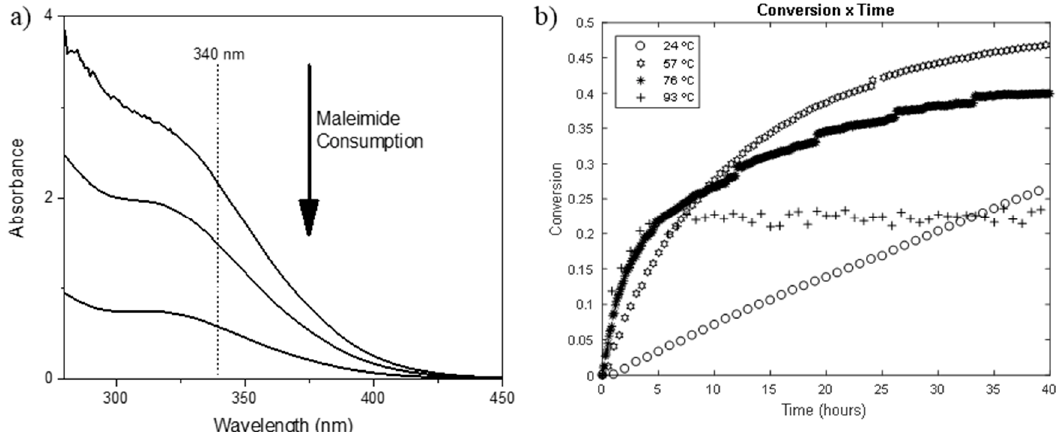
Figure 1. ( a ) UV-Vis spectra showing the decrease of absorbance attributed to the disappearance of N -hydroxymaleimide (NHM) when reacted with furfuryl alcohol at room temperature, and ( b ) plot of product conversion vs. time for different reaction temperatures for the same reacting system obtained via UV-Vis.